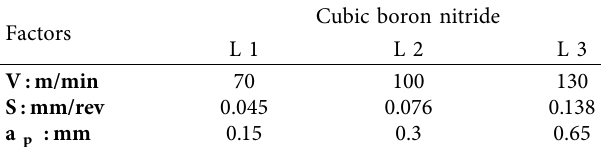
Table 2: Machining factors.